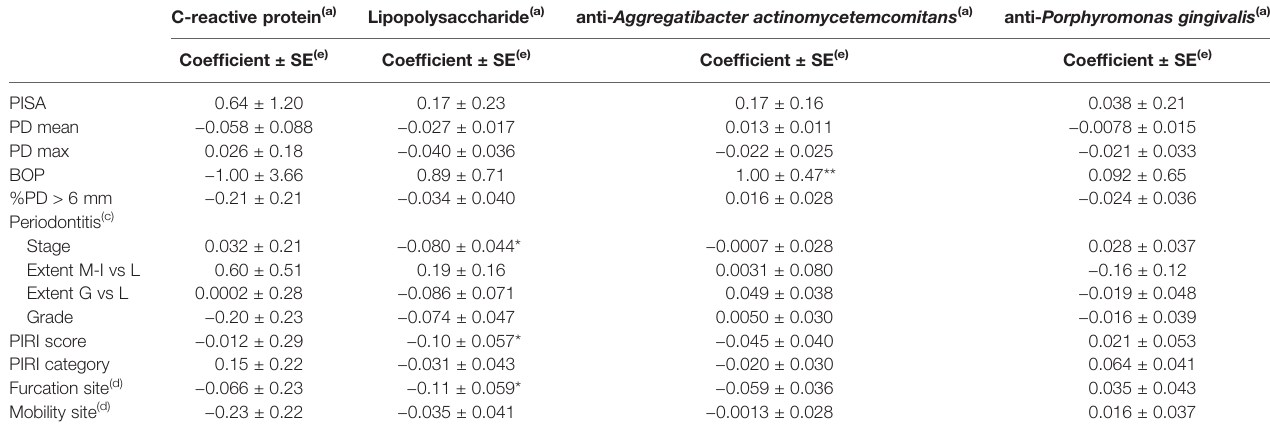
TABLE 1 | Relationship between periodontal parameters and the blood concentrations of CRP and LPS, Aa , and Pg antibodies. C-reactive protein